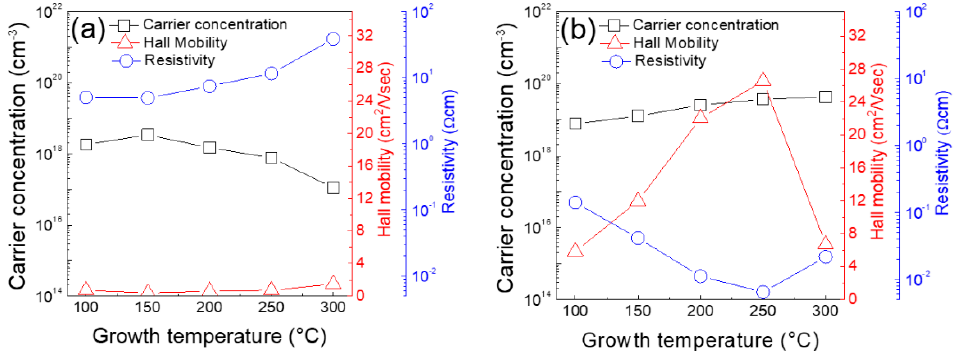
Figure 8. Carrier concentrations, Hall mobilities, and resistivities of ( a ) SH-SnO 2 and ( b ) SO-SnO 2 films as a function of growth temperature.